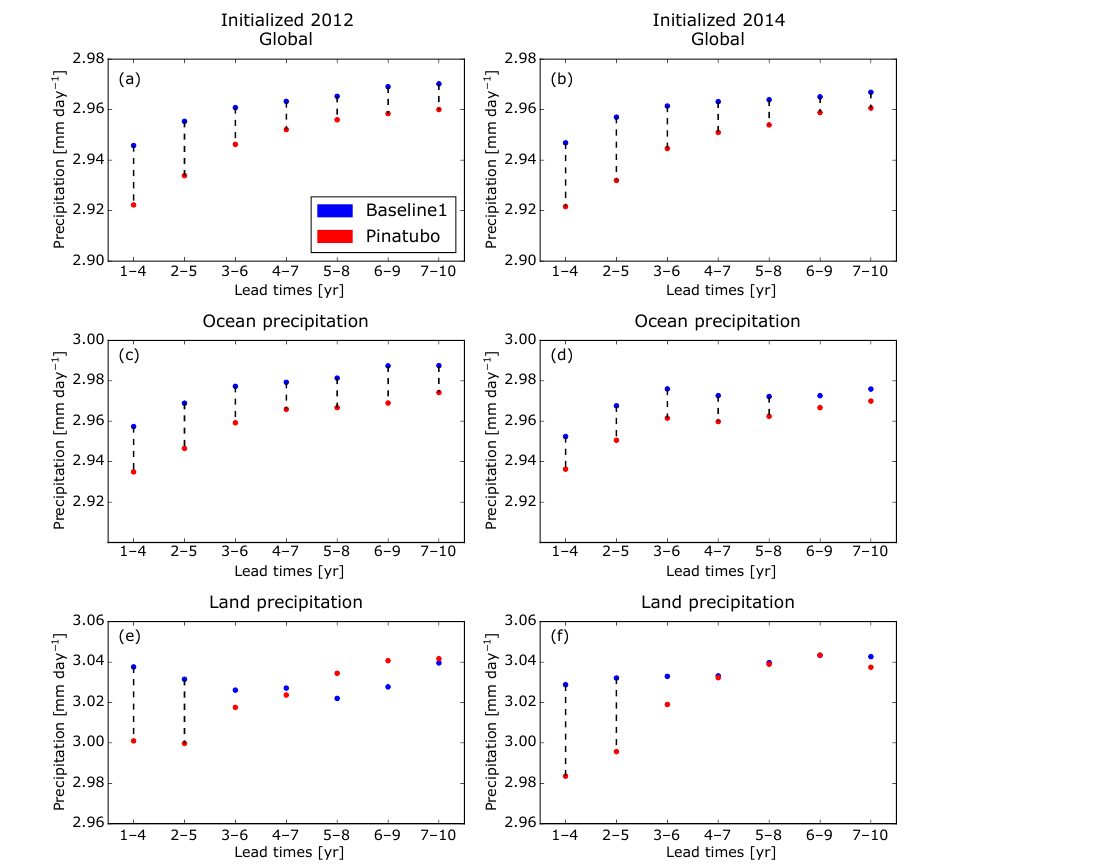
Figure 8. Same as Fig. 2, but for precipitation (PR) and different regions. (a, b) Global mean, (c, d) ocean only, and (e, f) land only. Dashed lines indicate significant differences between the values at the 5% level.